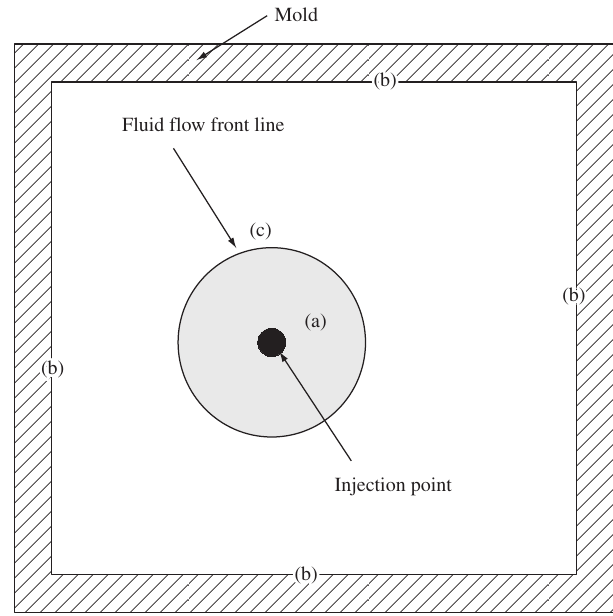
Figure 1. Schematic representation of the injection